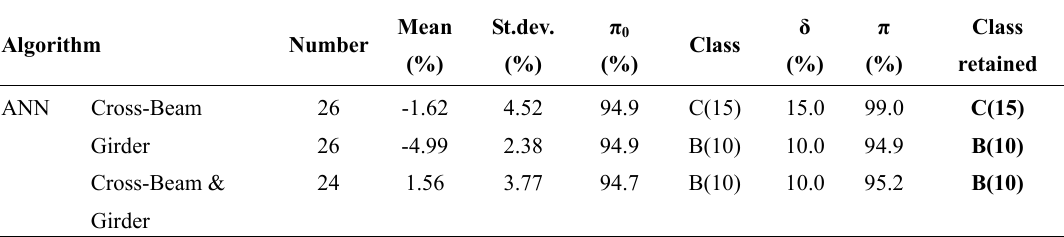
Table 5. Accuracy results of GVW from various B-WIM algorithms (Geumdang Bridge).